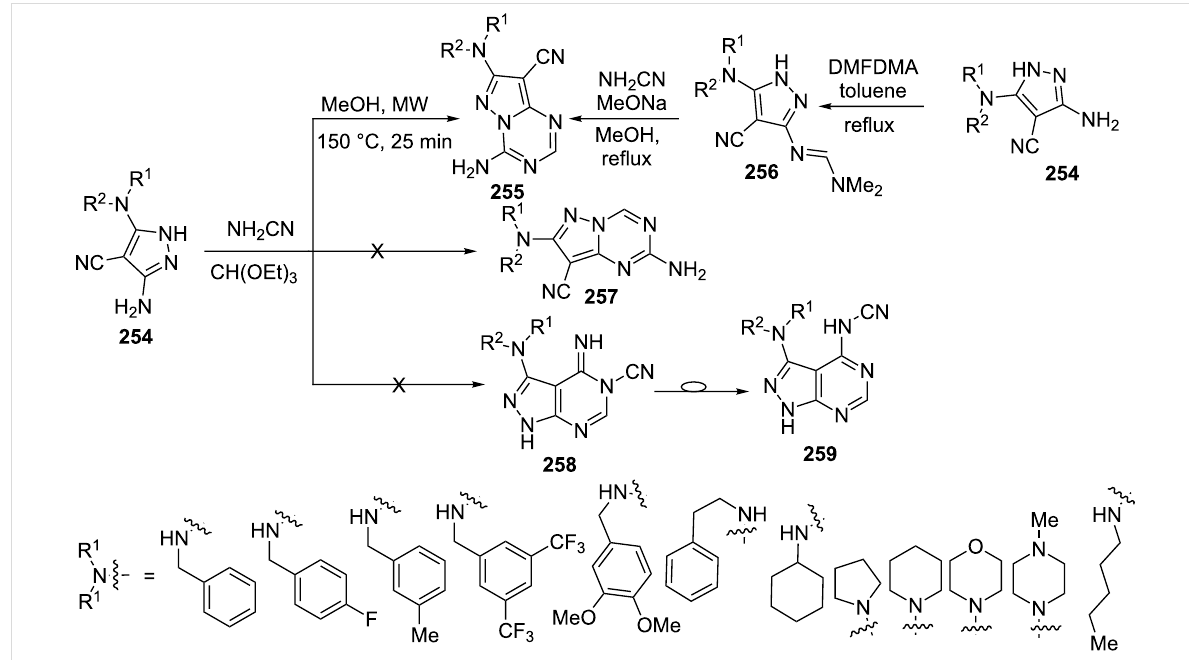
Scheme 70: Microwave-assisted synthesis of 4-aminopyrazolo[1,5- a